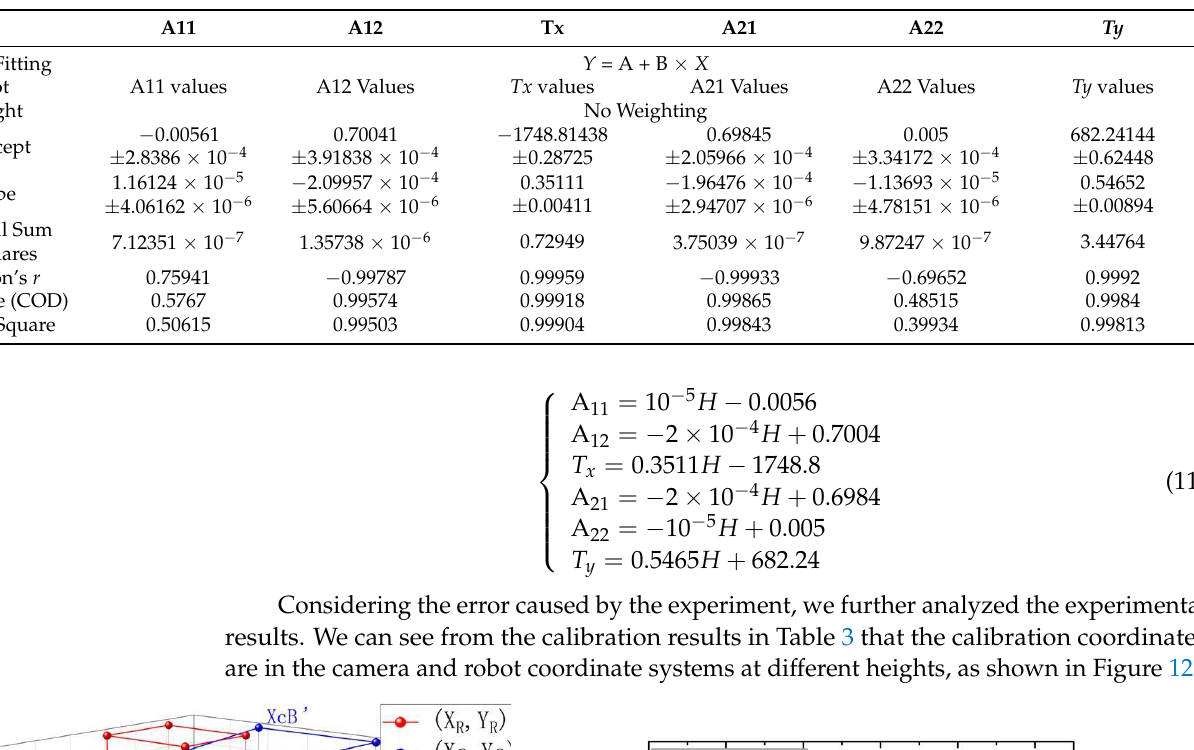
Table 5. Rigid transform matrix parameters fitting table.